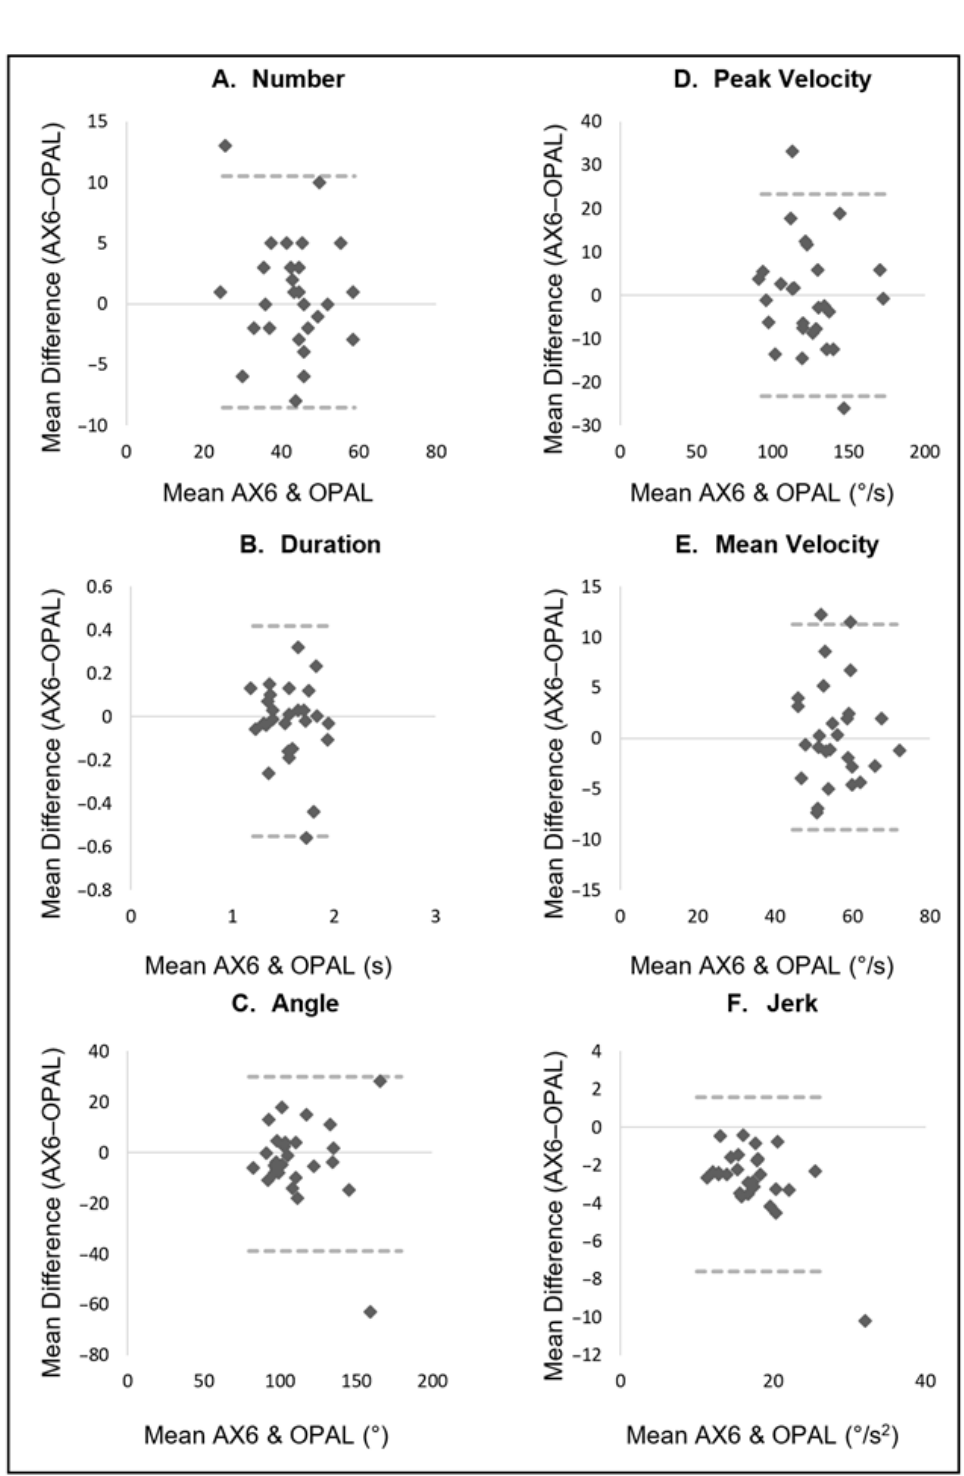
Figure 3. Turning Course task: Bland–Altman plots displaying agreement between AX6 and OPAL for ( A ) Number, ( B ) Duration, ( C ) Angle, ( D ) Peak velocity, ( E ) Mean velocity, ( F ) Jerk.